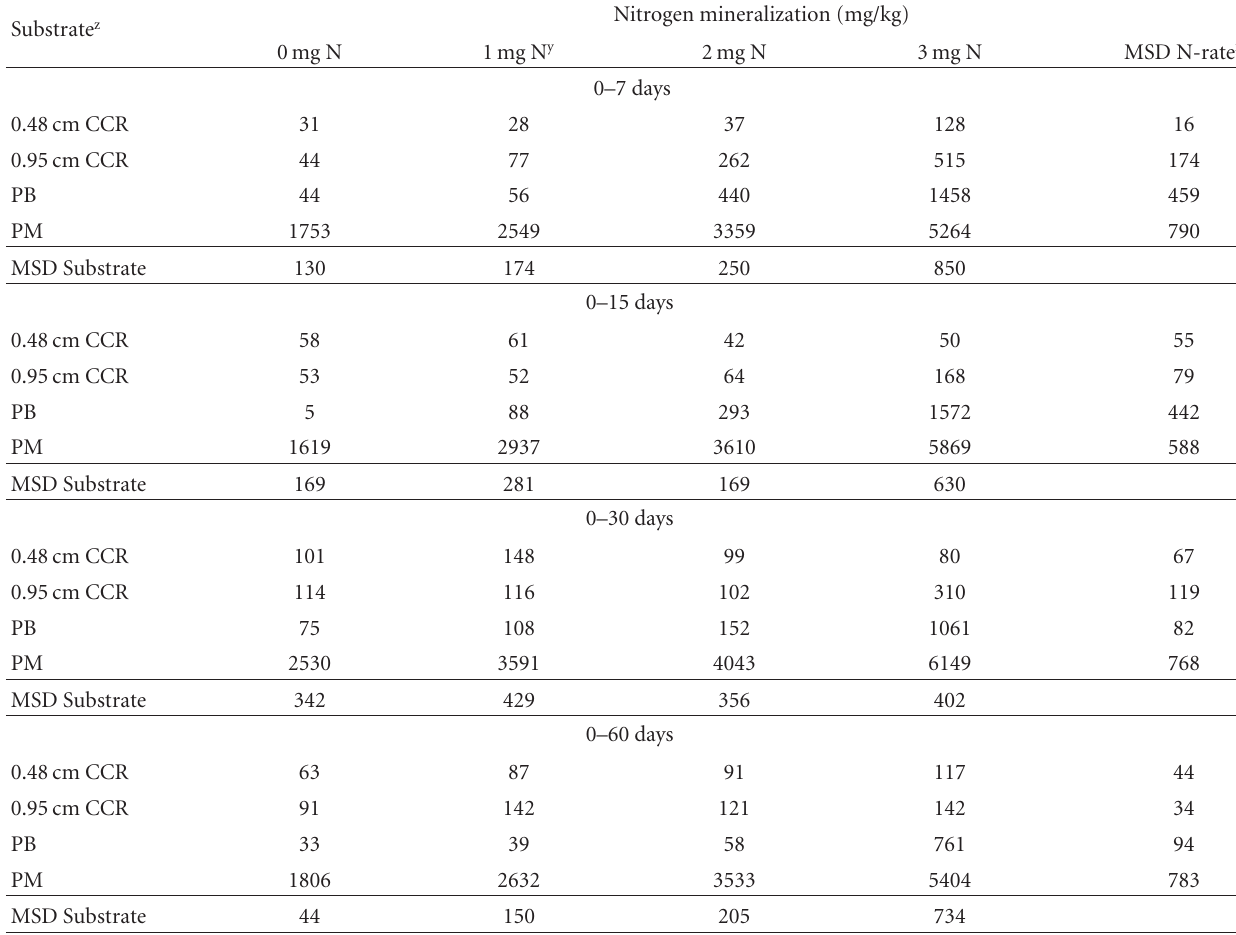
Table 5: Total inorganic nitrogen (NH 4 and NO 3 ) mineralization in clean chip residual, pine bark and peatmoss substrates. Substrate